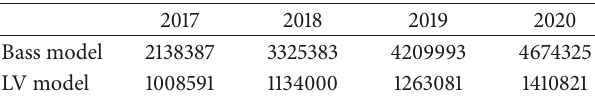
Table 6: Forecasting of BEV ownership from 2017 to 2020 based on the two